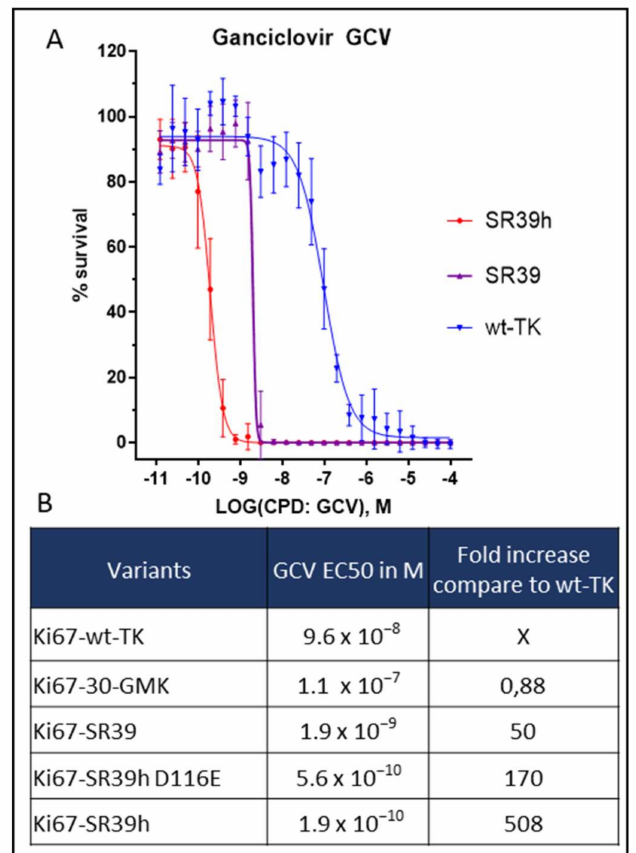
Figure 1. EC50 of ganciclovir (GCV) in cell expressing different thymidine kinase (TK) variants. Five different variants of TK from Herpes Simplex virus were investigated for their efficacy as a suicide gene in embryonic stem cells HS420 (hESC), in the presence of GCV: wt TK, 30 GMK, SR39, SR39h D116E, SR39h. All TK variants were expressed under the control of the cell cycle-dependent Ki67 promoter. ( A ) GCV EC50 curves in hESC expressing TK, SR39, or SR39h ( n = 3; GCV exposure time was 96 h). Number of surviving cells was monitored using bioluminescent ATP-based assay. ( B ) Summary table of EC50 values of all tested TK